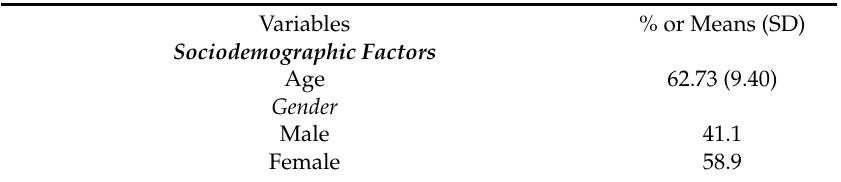
Participants’ sociodemographic characteristics, Internet experience and perspective, and social